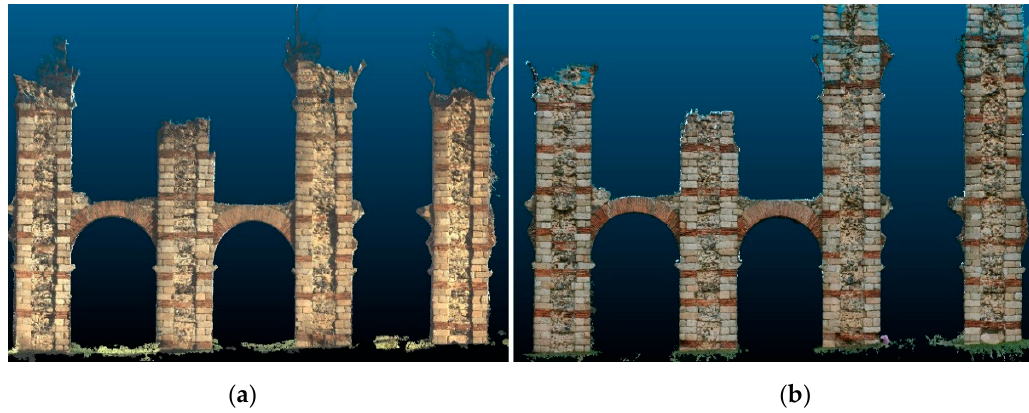
Figure 8. Comparison between points clouds resulting from both systems (with a data capture distance of 12 m): ( a ) Prototype and VSLAM-photogrammetric algorithm; and ( b ) Canon camera EOS 1300D with Agisoft Metashape software.